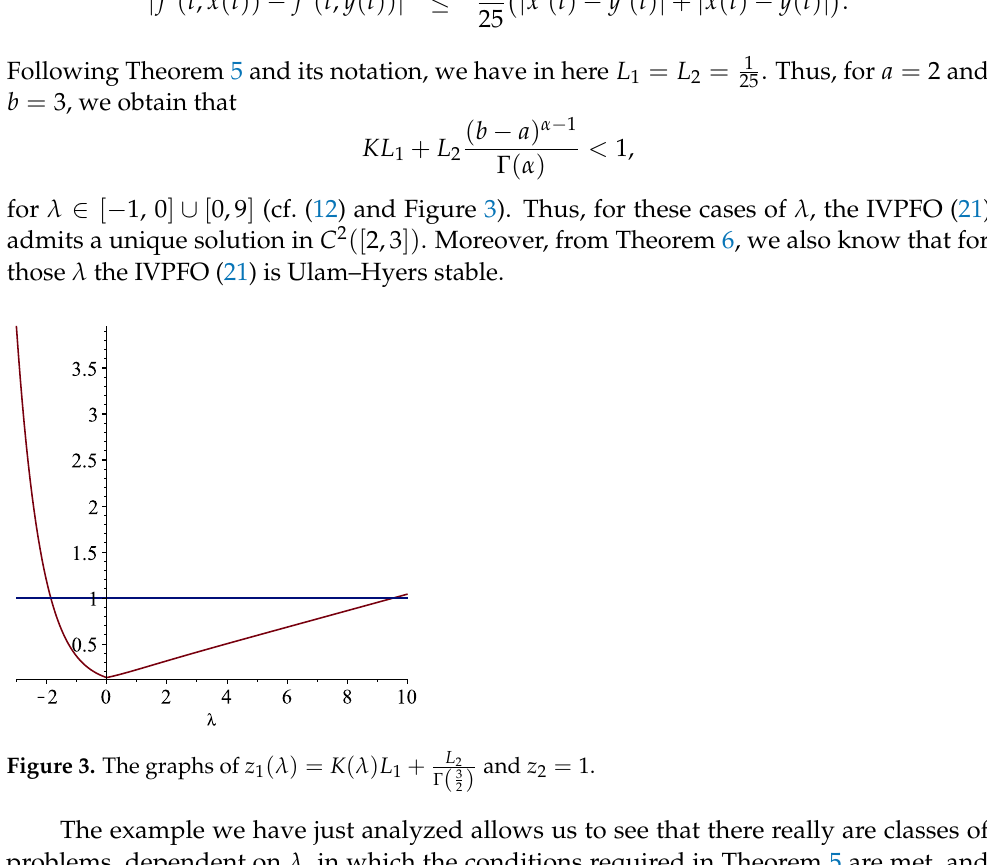
Figure 3. The graphs of z 1 ( λ ) = K ( λ ) L 1 + L 2